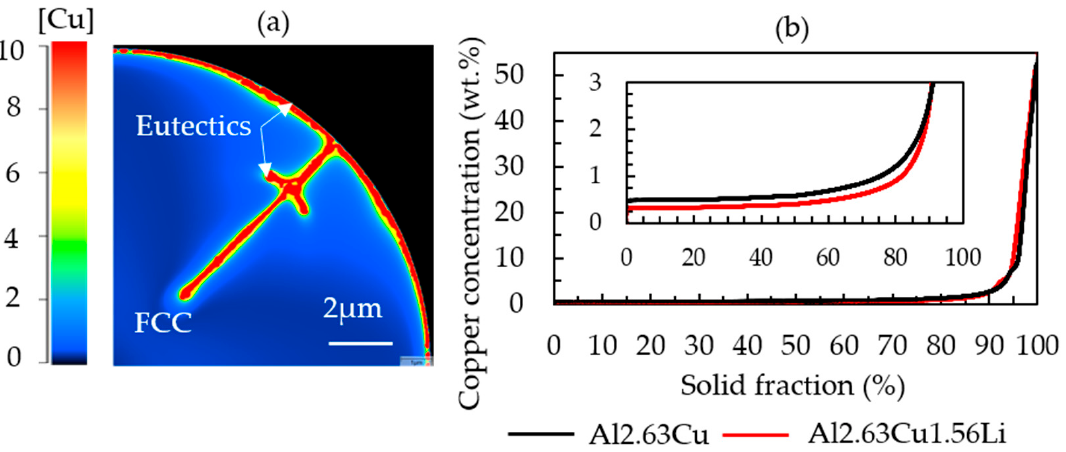
Figure 7. ( a ) Simulated microstructure of a completely solidified Al ‐ 2.63Cu ‐ 1.56Li powder showing the copper distribution. ( b ) Sorted local copper concentration values in Al ‐ 2.63Cu ‐ 1.56Li and Al ‐ 2.63Cu.